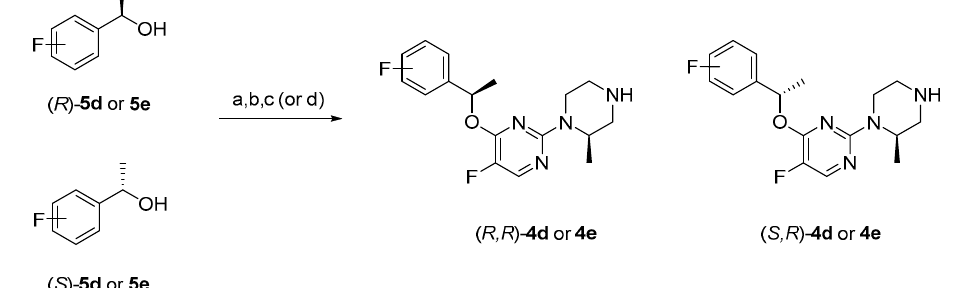
Scheme 3. Synthesis of the optically active pyrimidine derivatives 4d – 4e . Reagents and conditions: